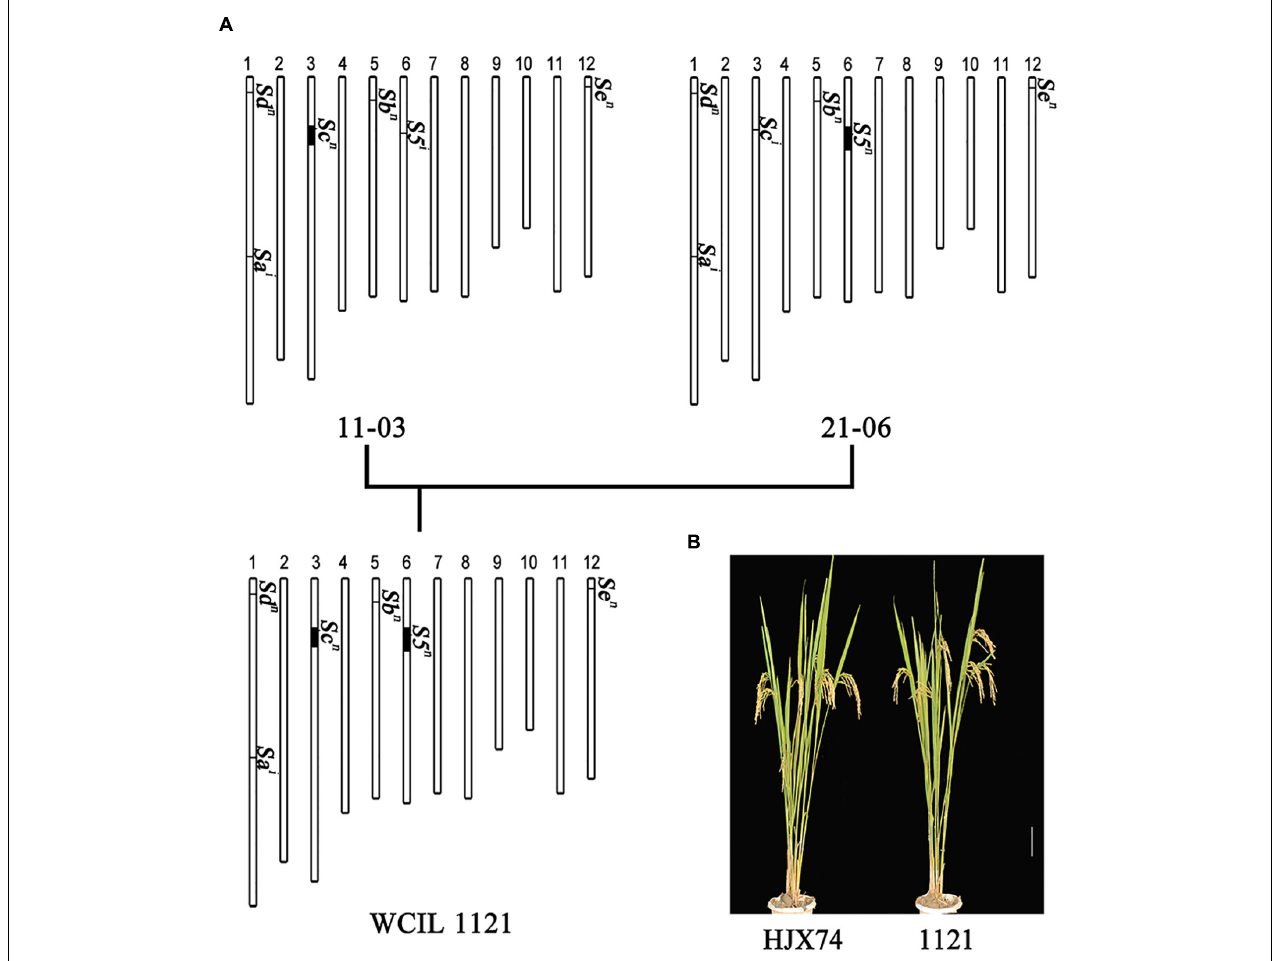
FIGURE 4 | Pyramiding of S n genes at the Sc and S5 loci in the HJX74 genetic background. (A) Development of WCIL 1121 by pyramiding of Sc n in the substitution segment of SSSL 11-03 and S5 n in the substitution segment of SSSL 21-06. Scale bar, 2 cm. Vertical bars represent rice chromosomes. Deep parts represent the substitution segments from donors and light parts represent the genetic background of HJX74. (B) Plant types of WCIL 1121 and HJX74. Scale bar, 10